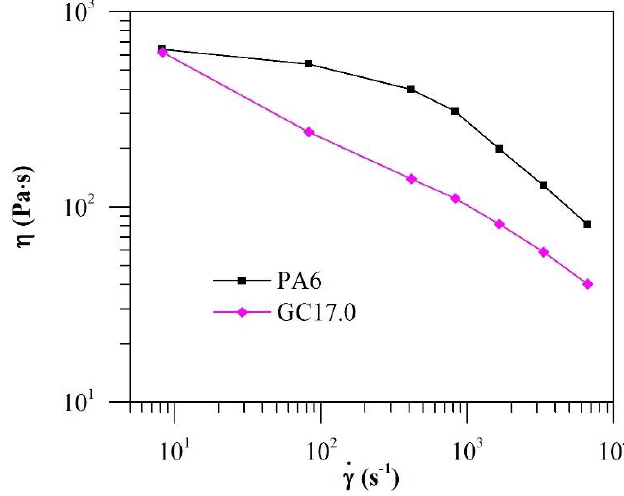
Figure 7. The η of PA6 and GC17.0 with change in γ̇ at 245 °C